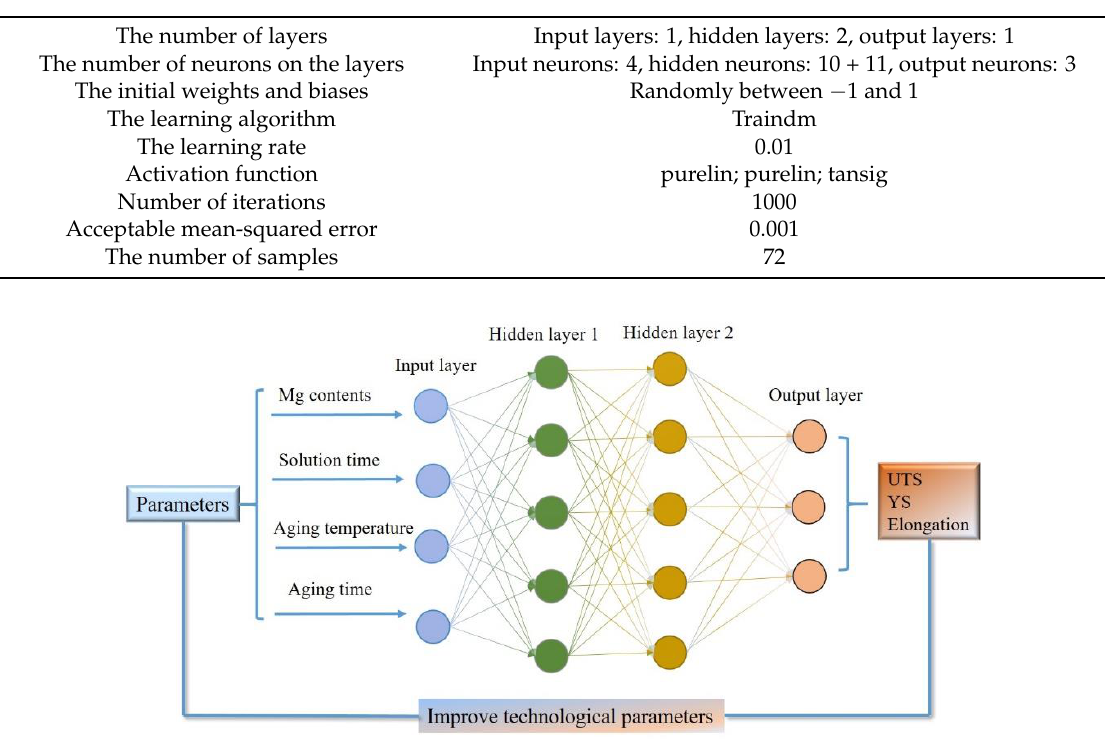
Table 3. The parameters of the proposed artificial neural network (ANN) model.